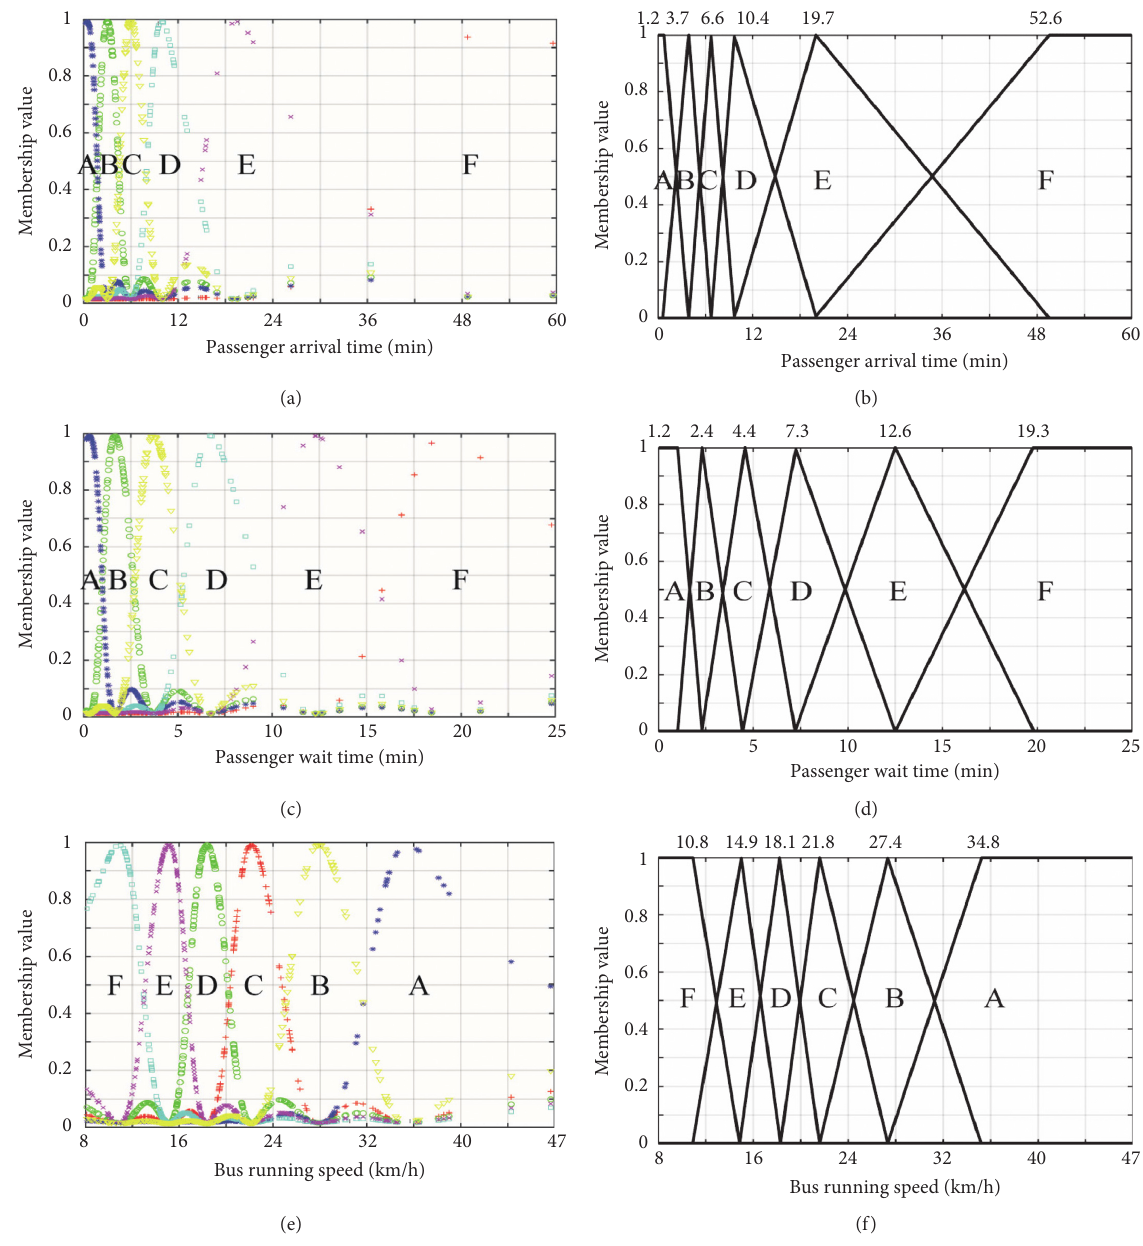
Figure 3: Membership functions for the anxious passenger group (a, c, and e) The original membership functions; (b, d, and f) the approximated membership